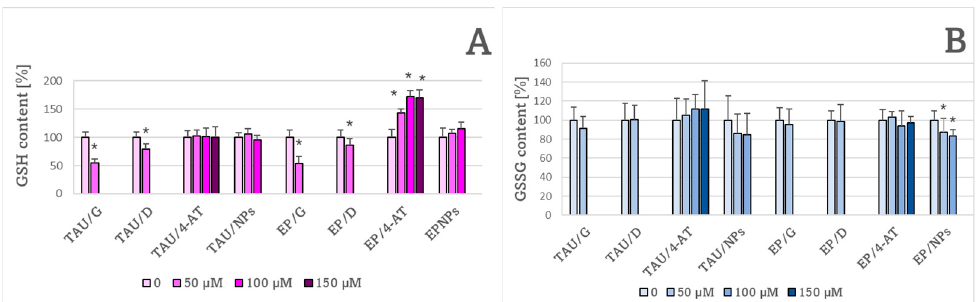
Figure 10. Effect of 50 µ M genistein (G) and delphinidin (D) and of various concentrations of 4-amino-TEMPO (4-AT) and nitroxide-containing redox nanoparticles (NPs) on GSH ( A ) and GSSG ( B ) content in TAU and EP cells after 24-h treatment. * p < 0.05 with compared to cells not treated with an antioxidant; n = 3. Delphinidin significantlyenhanced while 100 µ M NPs significantly decreased lipid peroxidation probed by BODIPY 11 in TAU cells. Nitroxide-containing nanoparticles also decreased lipid peroxidation in EP cells (Figure 11). It should be noted that the level of lipid peroxidation was higher in EP than in TAU cells (Figure